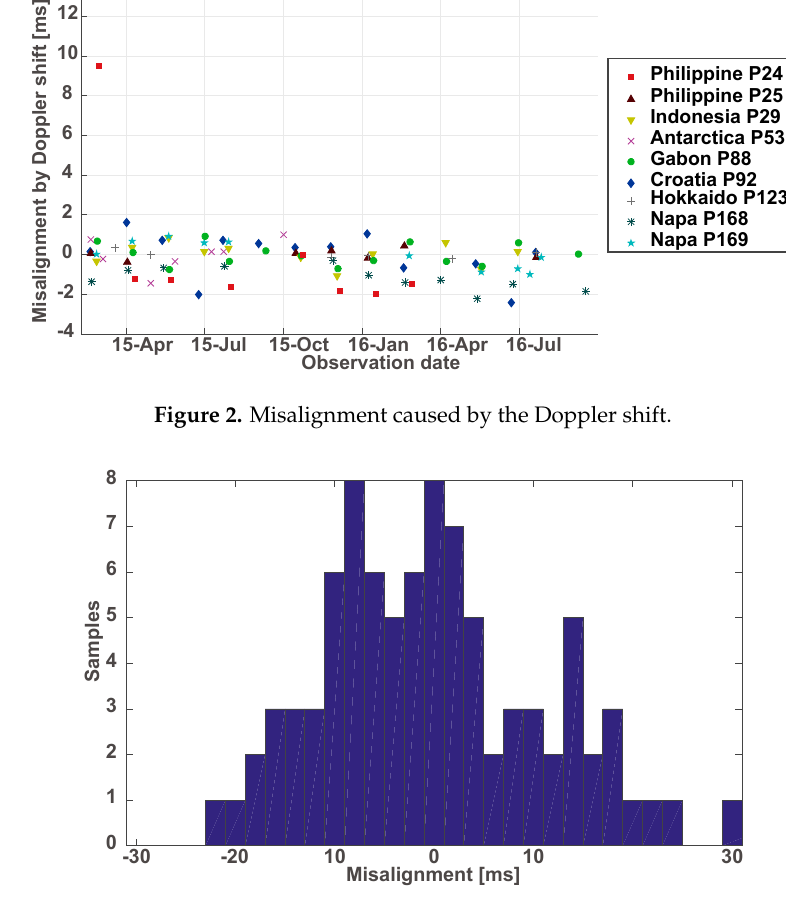
Figure 3. Remaining misalignment from ideal timing after subtracting the Doppler shift.